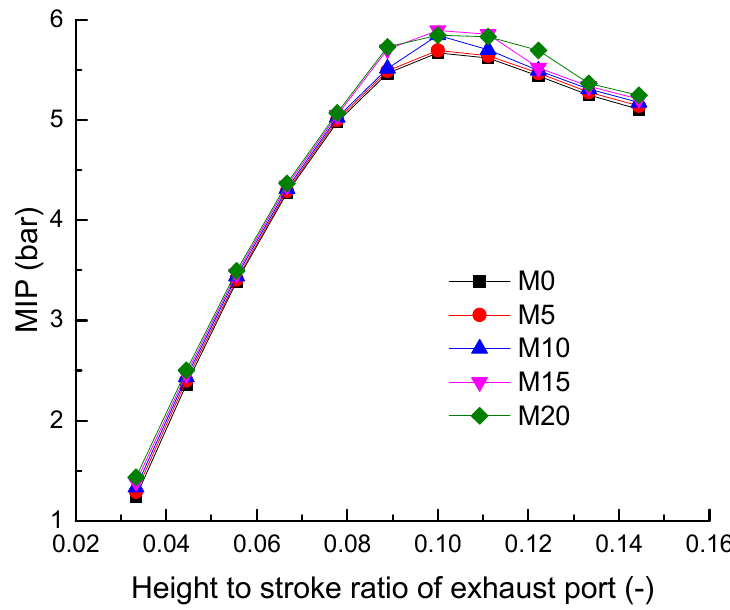
Figure 5. MIP for different height to stroke ratios of exhaust ports.